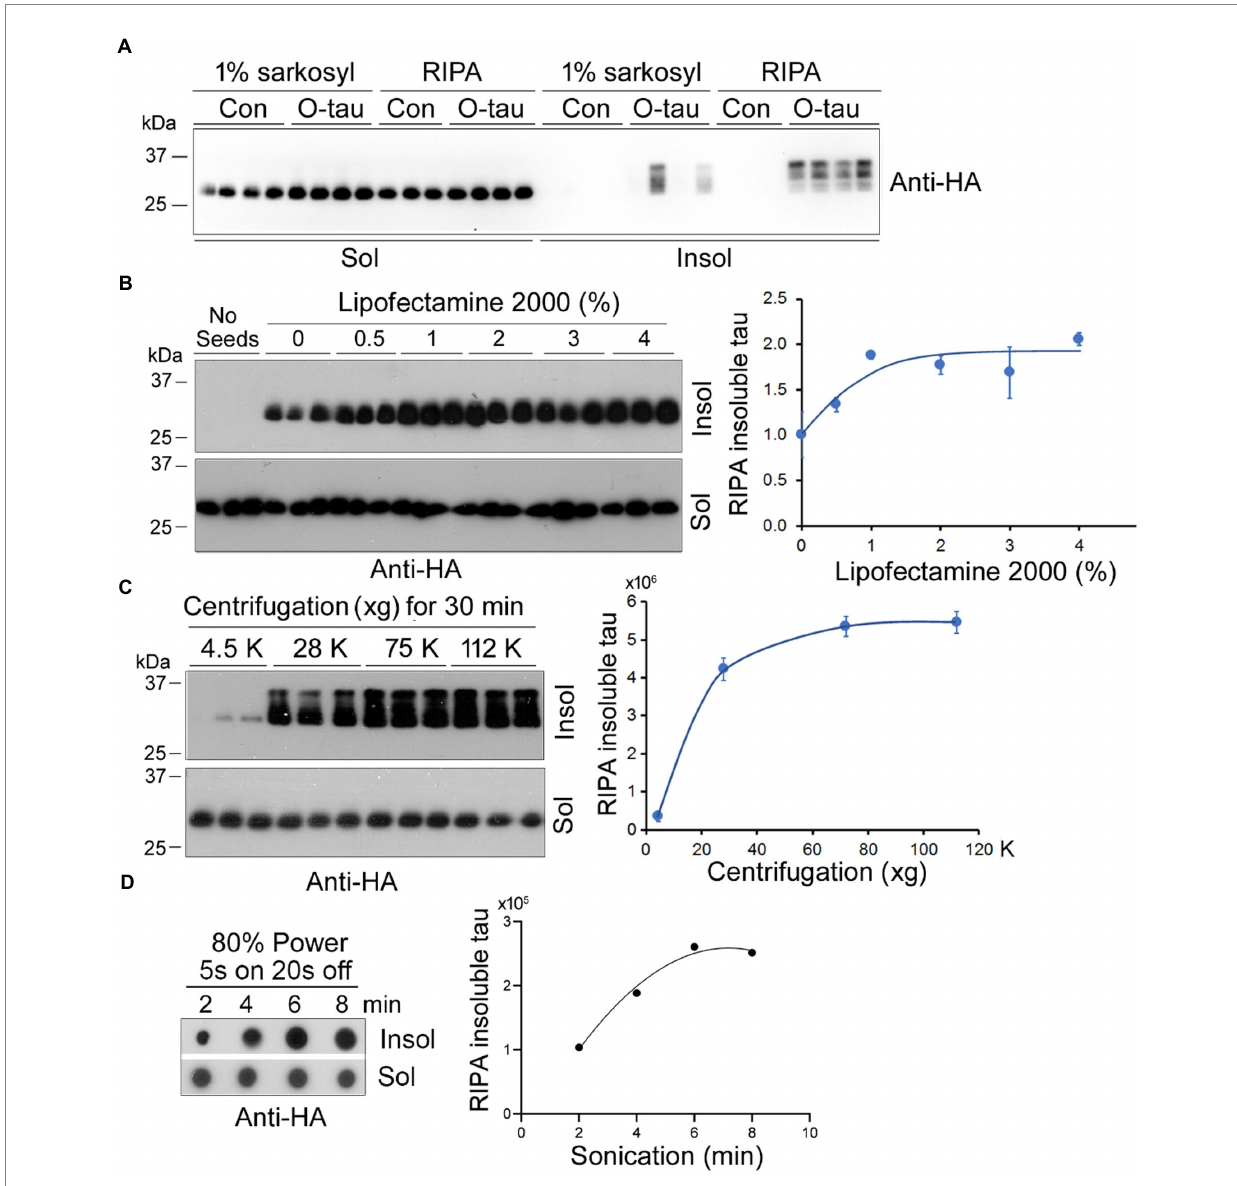
FIGURE 4 Optimization of the seeded tau aggregation assay. (A) RIPA buffer lysed the cells effectively. HEK-293FT cells in triplicate or quadruplicate were transiently expressed HA-tau 151-391 and treated with AD O-tau (0.5 A.U.) 6 h after transfection. The cells were lysed in 150 μ L RIPA buffer on ice for 20 min or in 1% sarkosyl at RT for 1 h by agitation. The soluble and insoluble fractions were obtained by ultracentrifugation and analyzed by Western blots with anti-HA. (B) Lipofectamine 2000 facilitated AD O-tau to seed tau 151-391 aggregation. HEK-293FT cells expressing HA-tau 151-391 in triplicate were cultured in 24-well-plate. AD O-tau (0.5 A.U.) was incubated with various concentrations of Lipofectamine 2000 in 25 μ L of Opti-MEM for 5 min and then added into the cell culture. The cells were lysed with RIPA buffer. RIPA-soluble and RIPA-insoluble taus were analyzed by Western blots. RIPA-insoluble tau was plotted against the concentration of Lipofectamine 2000 used for delivering AD O-tau. (C) RIPA-insoluble tau was sedimented at 75,000 xg for 30 min. Cell lysates with RIPA buffer were centrifugated at various g for 30 min. RIPA-soluble and -insoluble taus were analyzed. RIPA-insoluble tau was plotted against centrifugal force. (D) Eight min bath sonication dissolved RIPA-insoluble tau. RIPA-insoluble fraction was sonicated for various times at 80% power, 5 s on and 3 s off and analyzed by immuno-dot blots developed with anti-HA. RIPA-insoluble tau was plotted against the sonication